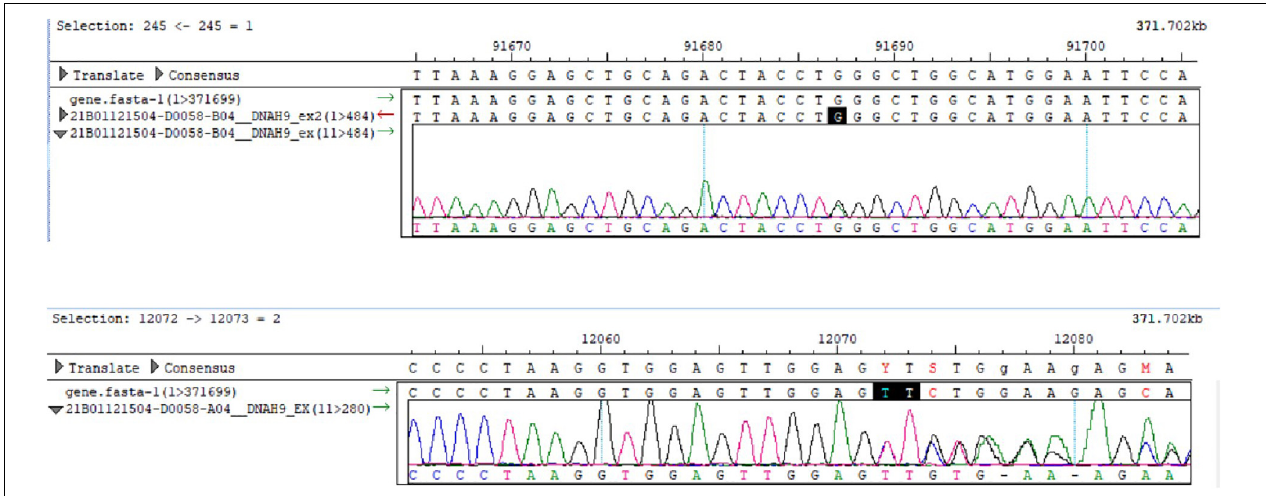
FIGURE 6 | The results of Sanger sequencing in this case. Compound heterozygous mutations in the DNAH9 gene are shown.